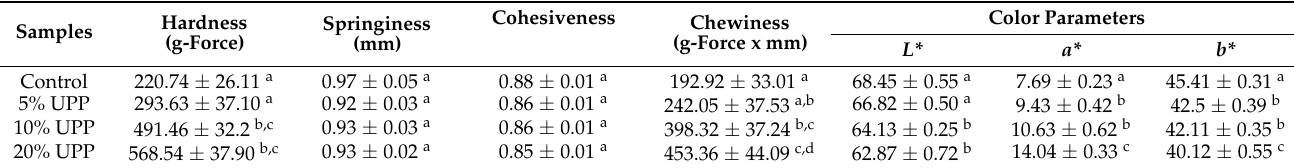
Table 4. Texture analysis and color profiles of pancakes with unripe papaya